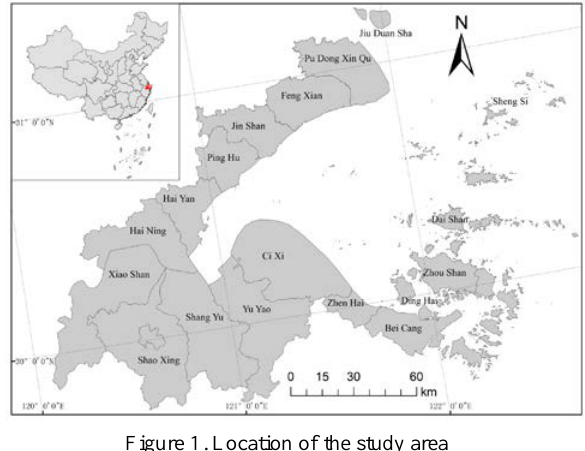
Figure 1. Location of the study area